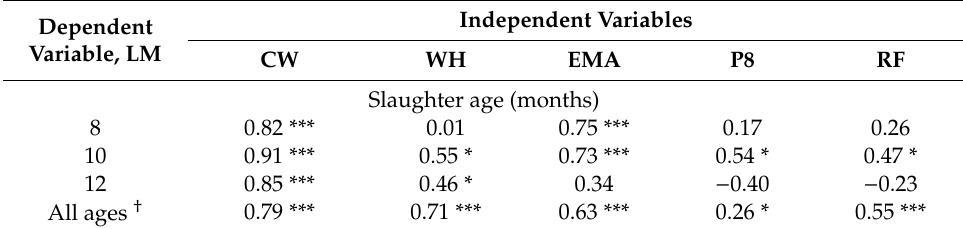
Table 2. Pearson correlation coe ffi cient of hind-leg muscles weight (LM, kg) with carcass weight (CW, kg), wither height (WH, cm), eye muscle area (EMA, cm 2 ), rump (P8, mm) and rib fat depths (RF, mm) in 8 ( n = 20), 10 ( n = 20), and 12 ( n = 20) month old steers and for data of all ages